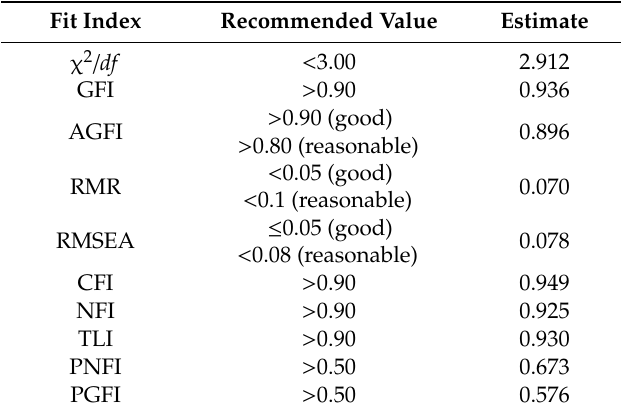
Figure 3. Standard loads, errors, and standardized regression weights of the structural equation model (SEM). Table 5. Goodness-of-fit indices summary of the SEM.